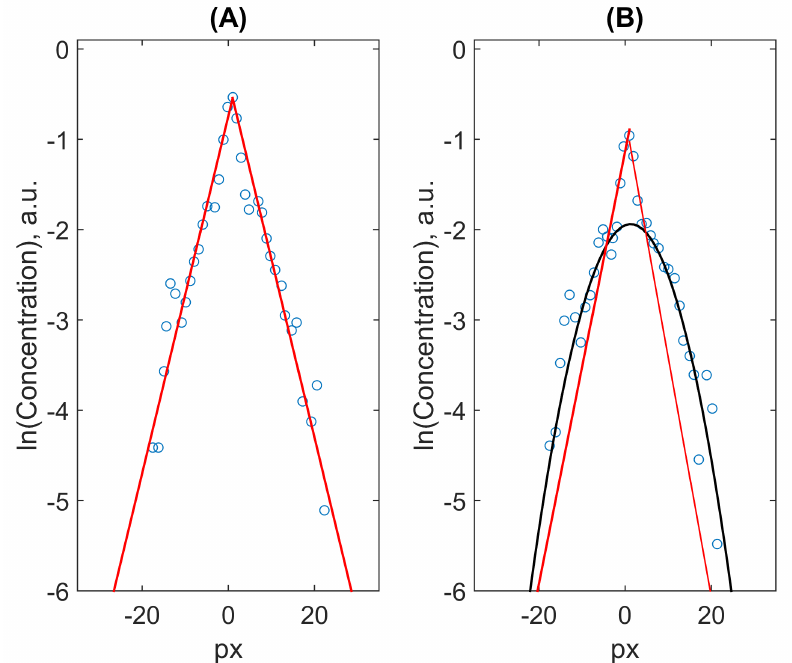
Figure 4. Examples of digitized data (markers) of two distributions taken from [39], for 59 s ( A ) and 72 s ( B ) and their fits by the Laplace (red lines) and the Gaussian (black parabola)